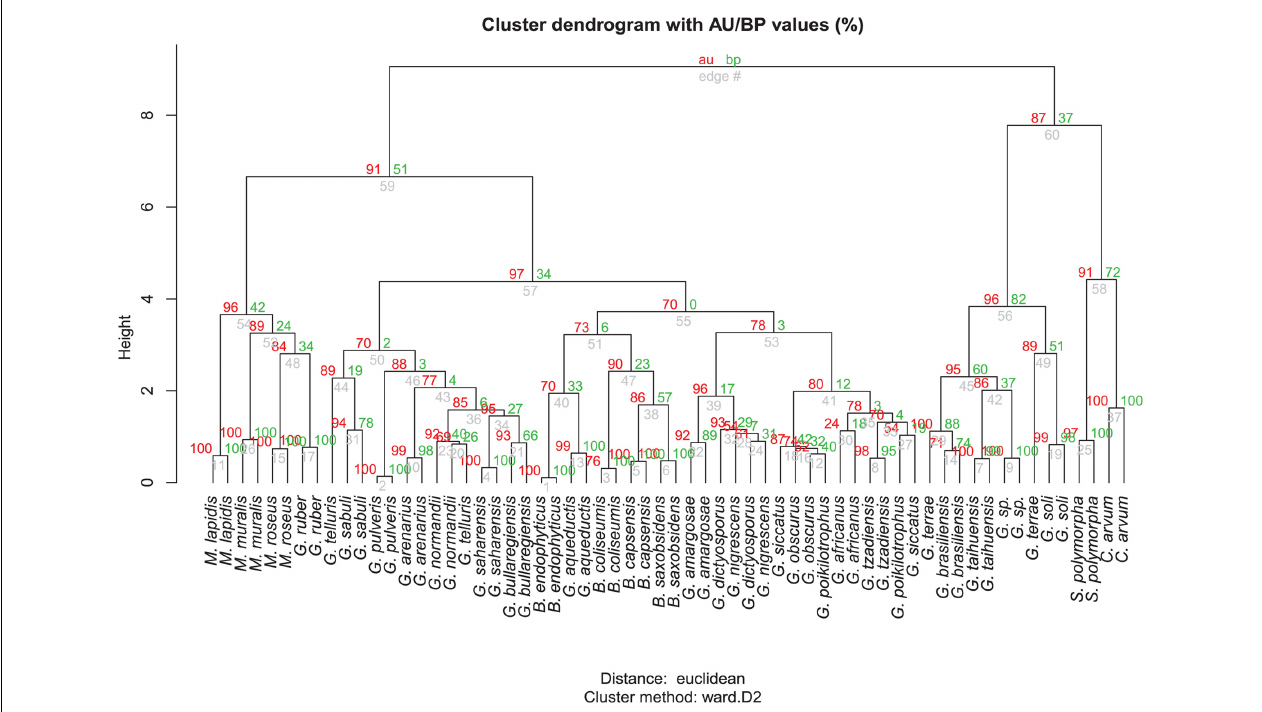
FIGURE 4 | Fatty-acids dendrogram estimated from the logit-transformed percent values as measured with the MIDI system using the Ward algorithm for agglomerative hierarchical clustering and euclidean distances using the pvclust package for the R statistical environment. Approximately unbiased (AU, left) and bootstrapping (BP, right) support values are shown above the